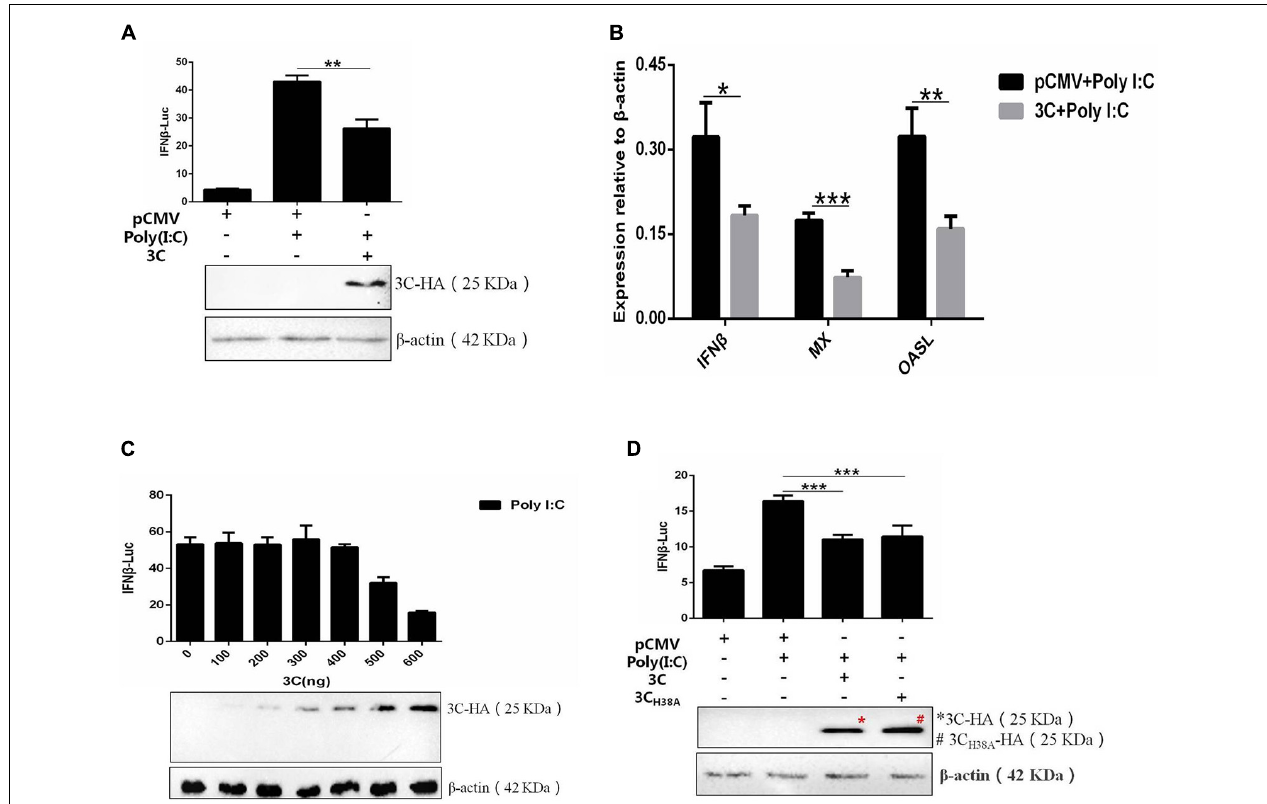
FIGURE 2 | The DHAV-1 3C protein inhibits the poly(I:C)-induced IFN- β signaling pathway. (A) pCMV-3C-HA, poly(I:C), IFN- β pro-Luc, and the reference plasmid (pRL-TK) were cotransfected into DEFs (except for the reference plasmid, pRL-TK, the transfection ratio was 3:1:1, and the amount of pRL-TK used for transfection was 1/20 that of IFN- β pro-Luc). Cell samples were collected 36 h after transfection, and IFN- β promoter activity was detected using a dual-luciferase reporting system to explore the effect of the 3C protein on activation of the IFN- β promoter induced by poly(I:C). (B) pCMV-3C-HA and poly(I:C) were cotransfected into DEFs (transfection ratio of 1:1). Cell samples were collected 36 h after transfection, and the total RNA was extracted from the samples. Quantitative PCR analysis of the effect of the 3C protein on poly(I:C)-induced IFN- β and IFN- β -induced MX and OASL mRNA levels. (C) A total of 0.3 µ g of poly(I:C), 0.3 µ g of IFN- β pro-Luc, the internal reference plasmid pRL-TK, and different amounts of pCMV-3C-HA were cotransfected into DEFs (the amount of pRL-TK transfected was 1/20 that of IFN- β pro-Luc). Thirty-six hours after transfection, cell samples were collected, and the dual-luciferase reporter system was used to detect IFN- β promoter activity to explore the effects of differences in 3C protein expression on IFN- β promoter activation. (D) pCMV-3C H 38 A -HA, poly(I:C), IFN- β pro-Luc, and the reference plasmid pRL-TK were cotransfected into DEFs (except the reference plasmid pRL-TK, the transfection ratio was 3:1:1, and the amount of pRL-TK transfected was 1/20 that of IFN- β pro-Luc). Thirty-six hours after transfection, cell samples were collected. The dual-luciferase reporter system was used to detect IFN- β promoter activity to explore the loss of 3C protease activity on IFN- β promoter activation induced by poly(I:C). * P < 0.05, ** P < 0.01, *** P < 0.001, compared with the control group.